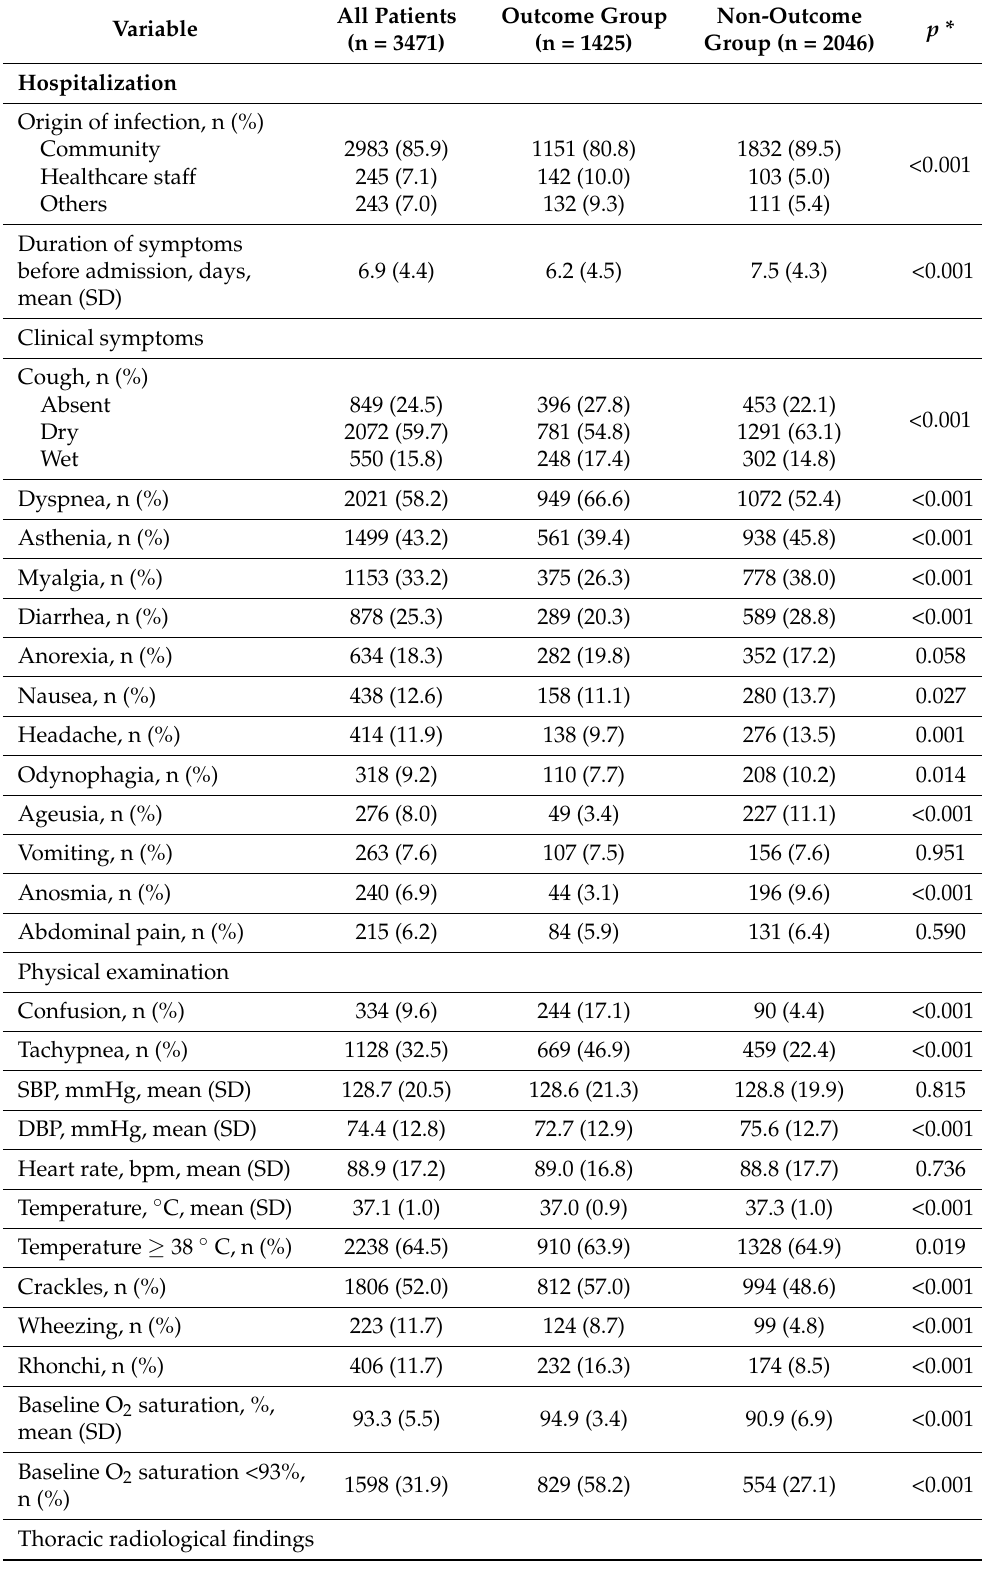
Table 2. COVID-19-related clinical manifestations and signs of study